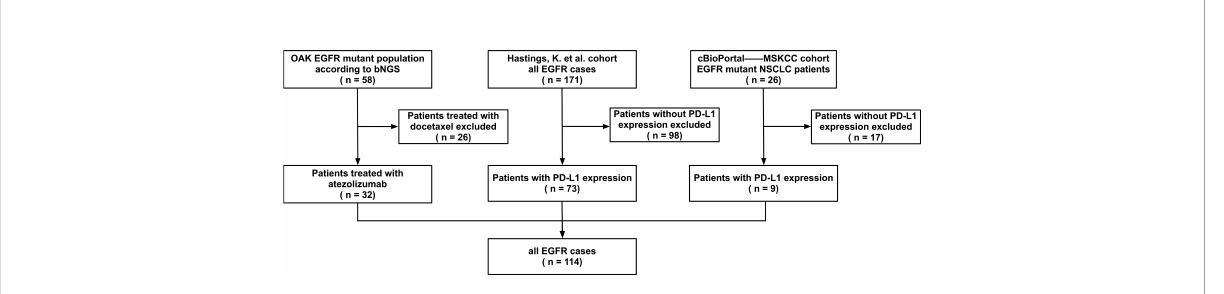
FIGURE 1 Patient selection. Epidermal growth factor receptor (EGFR) mutated non-small cell lung cancer patients treated with immune checkpoint inhibitors from OAK, Memorial Sloan Kettering Cancer Center (MSKCC), and Hastings et al. cohorts were selected (n = 229). A total of 114 patients who had the information of programmed cell death ligand 1 (PD-L1) expression were